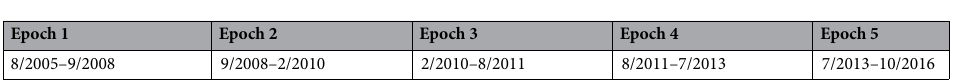
Table 1. Epochs subdivision (time format mm/yyyy). Table of the subdivision of the entire time period in 5 epochs of variable duration, based on resolution requirement of 4D tomographic images.